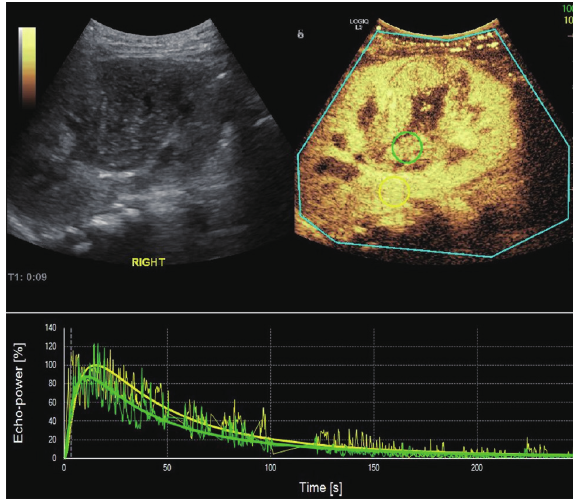
Figure 3 The TIC of the mass parenchyma and the right kidney tissue. The mass (the green curve) enhanced rapidly and the echo-power reached the peak intensity rapidly, but the peak was lower than normal renal parenchyma (the yellow curve). And then it washed out gradually and cleared out completely.